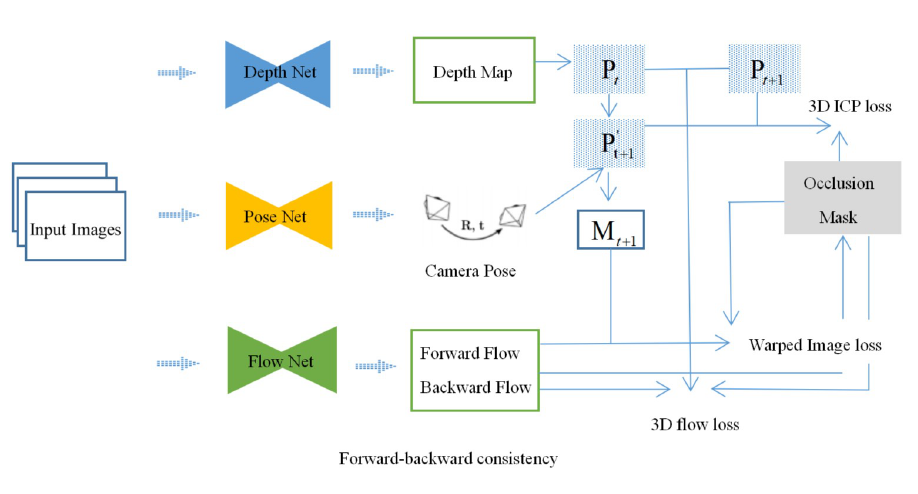
Figure 1. Overview of our system. It consists of three task-specific sub-networks targeting at estimating monocular depth, optical flow, and camera motion. Rich geometric constraints are employed extracting from the natural structure of the scene. Here M denotes input image and P denotes point